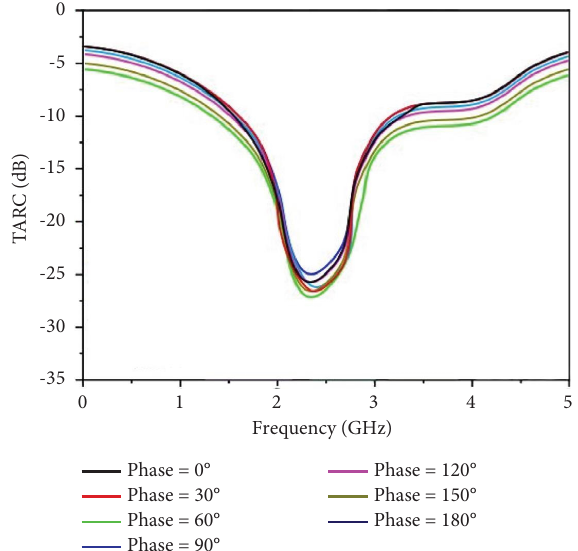
Figure 22: TARC curves of the proposed four-port MIMO antenna array.